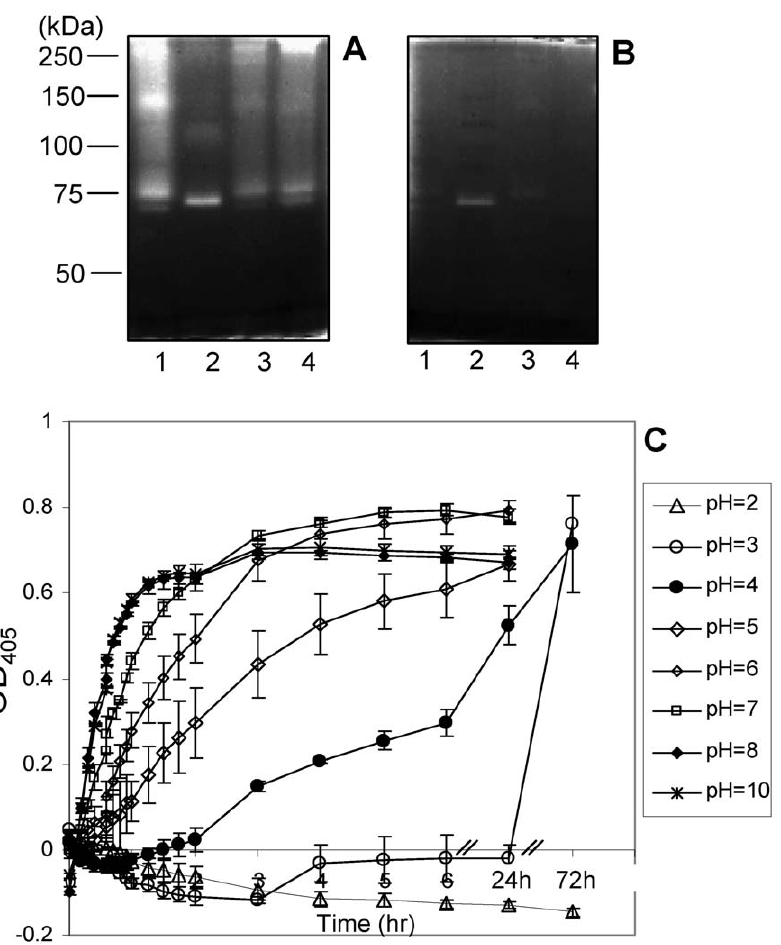
Figure 6. Gliadin zymography (6%) of Rothia strains and pH activity analysis. In the zymogram gels 150 m l cells (OD 620 5.0) were applied per lane. Lane 1, strain WSA-2B ( R. mucilaginosa ); lanes 2: strain WSA-8 ( R. aeria ), lane 3: strain WSA-26 ( R. mucilaginosa ); lane 4: strain ATCC 25296 ( R. mucilaginosa ). A, gel developed at pH 7.0; B, gel developed at pH 3.0. C, Z-YPQ-pNA (200 m M) hydrolysis by WSA-8 cells (OD 620 1.2) measured in 20 mM Tris solutions ranging in pH from 2.0 to 10.0. Measurements at 405 nm were carried out hourly for the first 6 hours and after 24 h and 72 h.